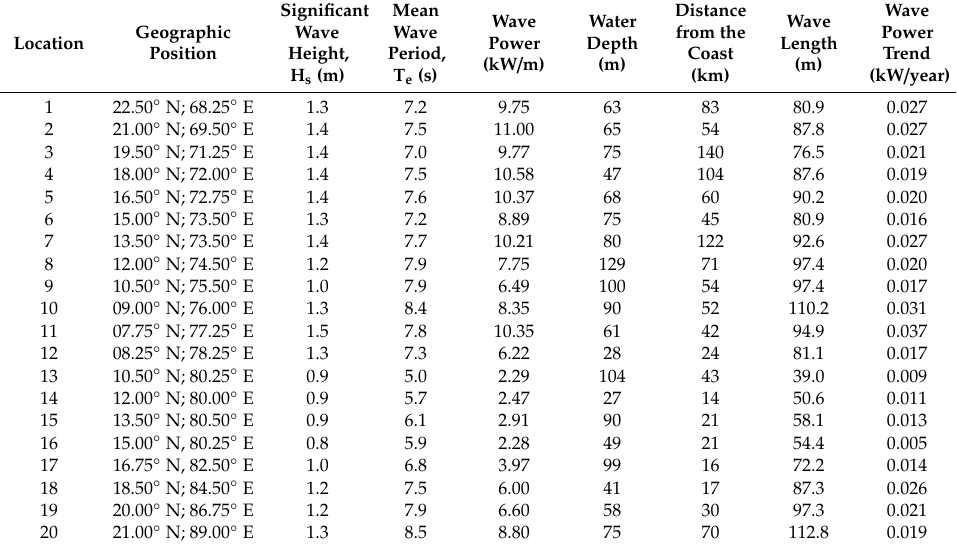
Figure 1. Map showing the 20 locations selected in the Indian shelf seas for the study along with the bathymetry chart. The two boxes indicate the locations where the change in wave power from deep to shallow waters is examined. Table 1. The annual average value of significant wave height, mean wave period, wave power, and wave length at the locations studied along with their geographical position and the trend in annual mean wave power during the 40 years.